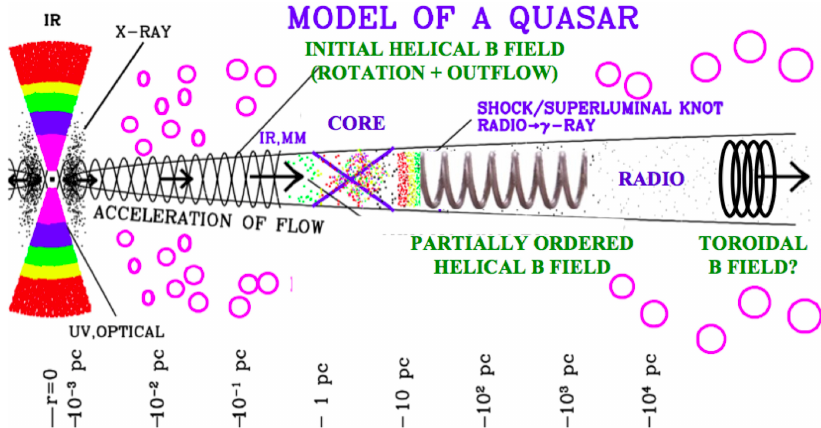
Figure 2. Modification of the well-known schematic of Marscher (e.g., [14]) to reflect the persistence of a helical magnetic-field component beyond the core region. It is expected that the toroidal component of this helical field should become more dominant with distance from the core, due to the more rapid decay of the longitudinal (poloidal)